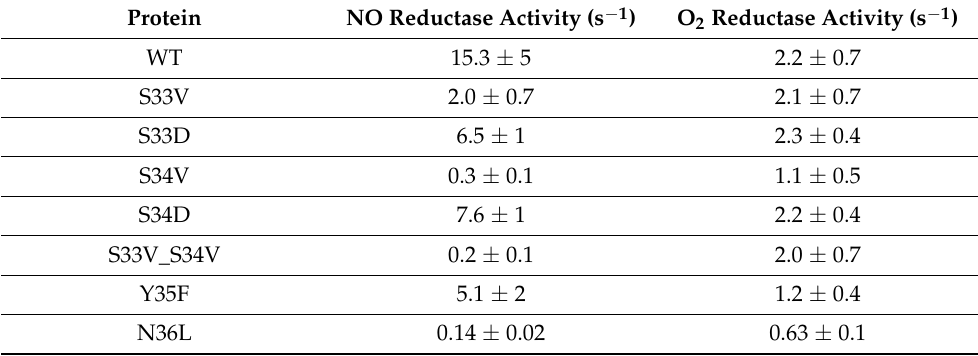
considering the protein concentration and iron and FMN contents for each